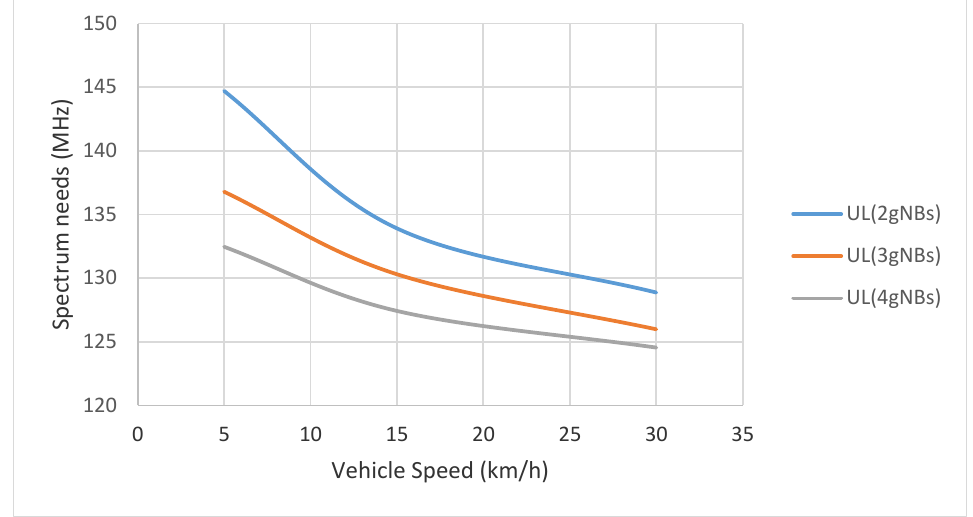
Figure 5. Uplink (UL) spectrum needs per gNB sector in the urban grid environment.